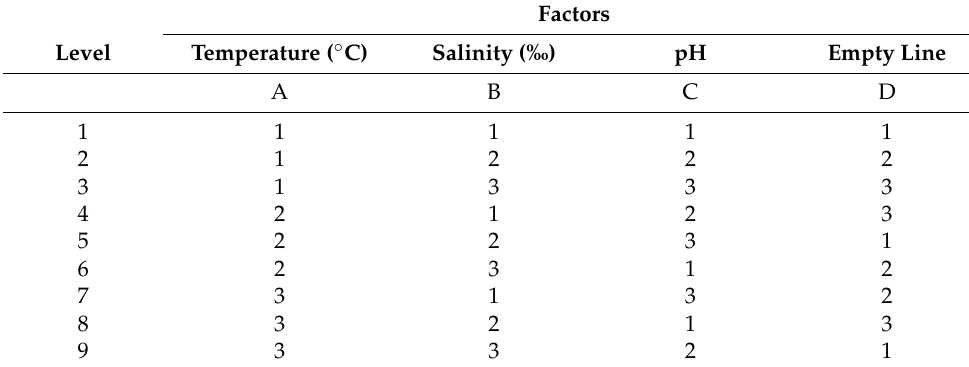
Table 2. Orthogonal experimental